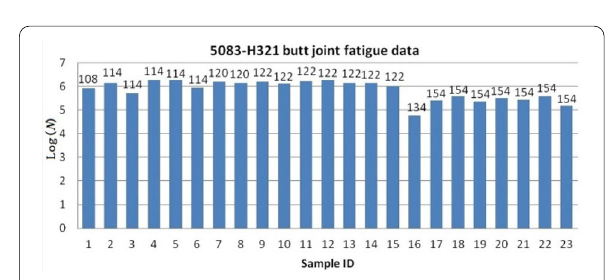
Figure 7 5083-H321 butt joint fatigue data